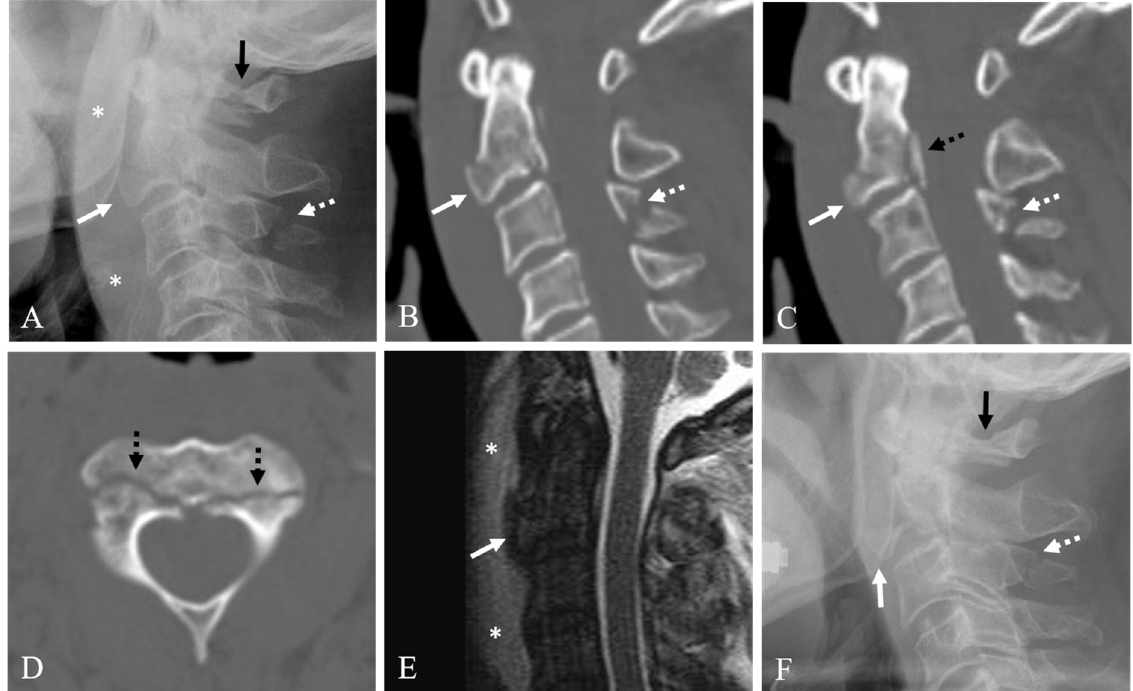
Figure 3. Lateral X-ray ( A ) and sagittal 2-dimensional (2-D) reconstructed computed tomography (CT) scans ( B , C ) showing anterior C2 tear drop (TD) fracture with 75% avulsion fracture ratio (white arrow), prevertebral soft tissue swelling (asterisks), C1 posterior arch fracture (dark arrow), posterior C2 body vertical fracture (dotted dark arrow), and C3 spinous process fracture (dotted white arrow). Axial CT scan ( D ) showing bilateral pedicle fracture (dotted dark arrows). Sagittal magnetic resonance imaging ( E ) showing anterior C2 TD fracture of C2 (white arrow) and prevertebral hematoma (asterisks). ( F ) At 12-month follow-up after Minerva brace, lateral X-ray showing displaced nonunion of anterior C2 TD fracture (white arrow) compressing the pharynx, and nonunion of C3 spinous process fracture (dotted white arrow) but solid fusion of C1 posterior arch fracture (dark arrow).